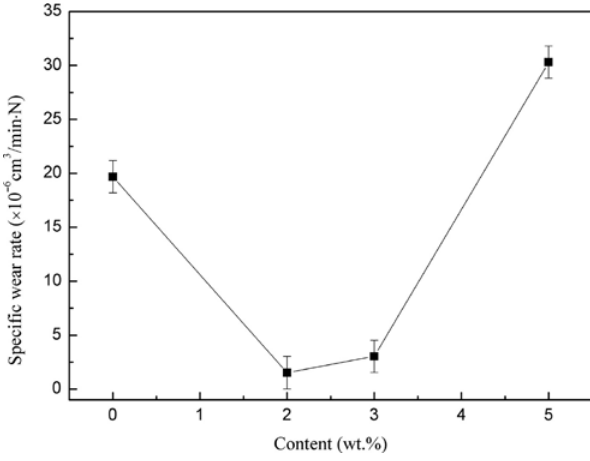
/PU composite coatings of 2